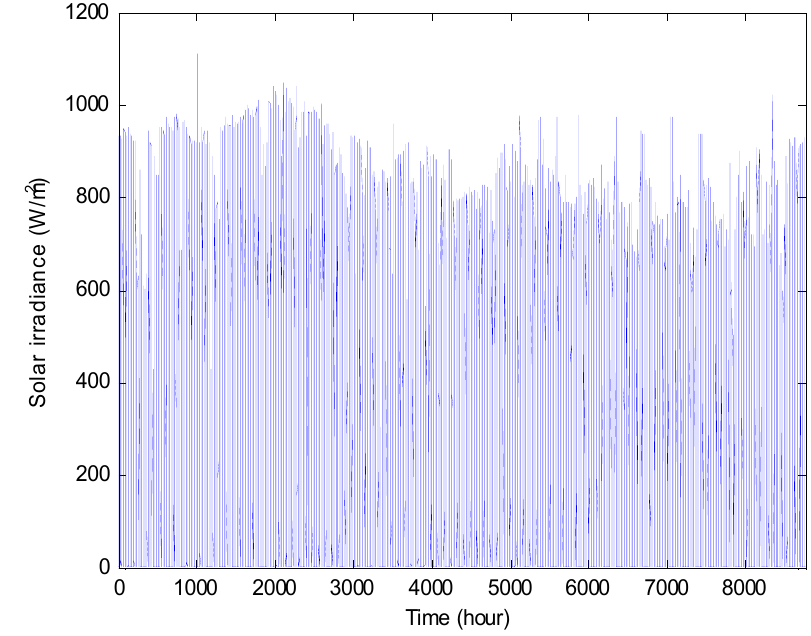
Figure 4. Hourly solar irradiance over the year (W/m 2 ).